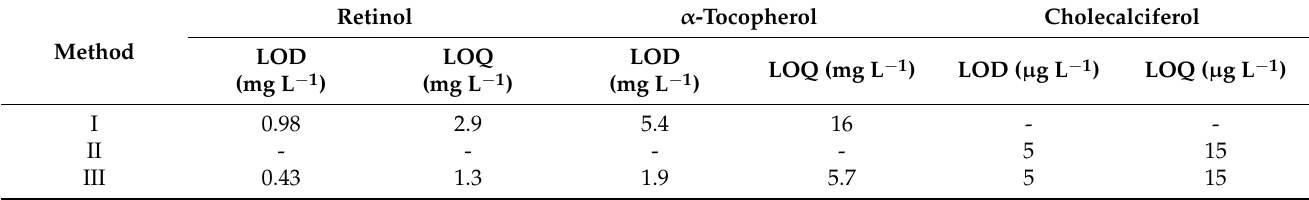
Table 7. Instrumental limit of detection (LOD) and limit of quantitation (LOQ) of each